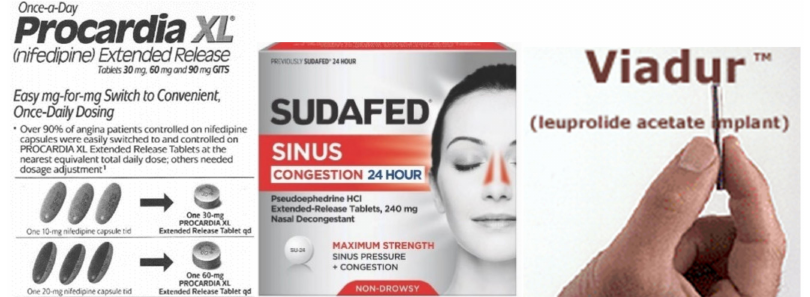
Figure 28. Example of osmotically controlled drug delivery systems (reproduced from [58–60] with permission from Pfizer Laboratories Div Pfizer Inc., Johnson & Johnson Consumer Inc. 2019